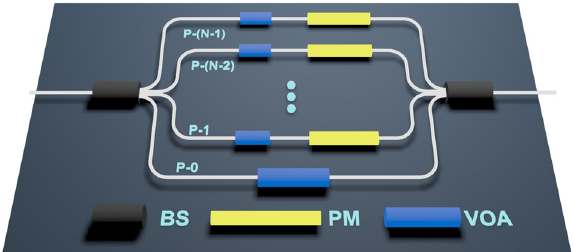
Fig. 3 A MMZI structure for improving the tuning range. In this scheme, each path owns a VOA. Adjusting attenuation ratios of these VOAs is equivalent to adjusting splitting ratios of the splitter and the